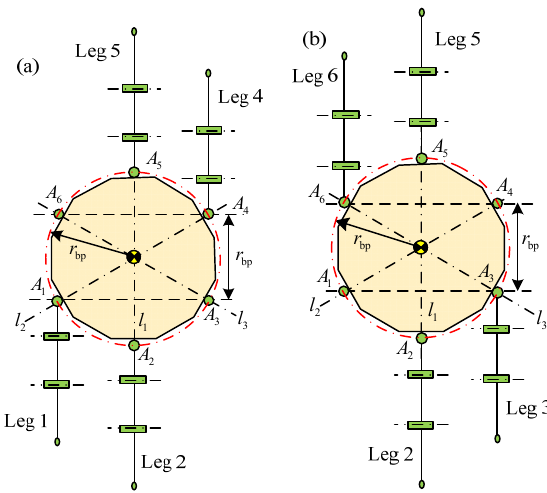
Figure 5. Working condition II of support phase: ( a ) support phase involving legs 1, 2, 4 and 5; and ( b ) support phase involving legs 2, 3, 5 and 6.